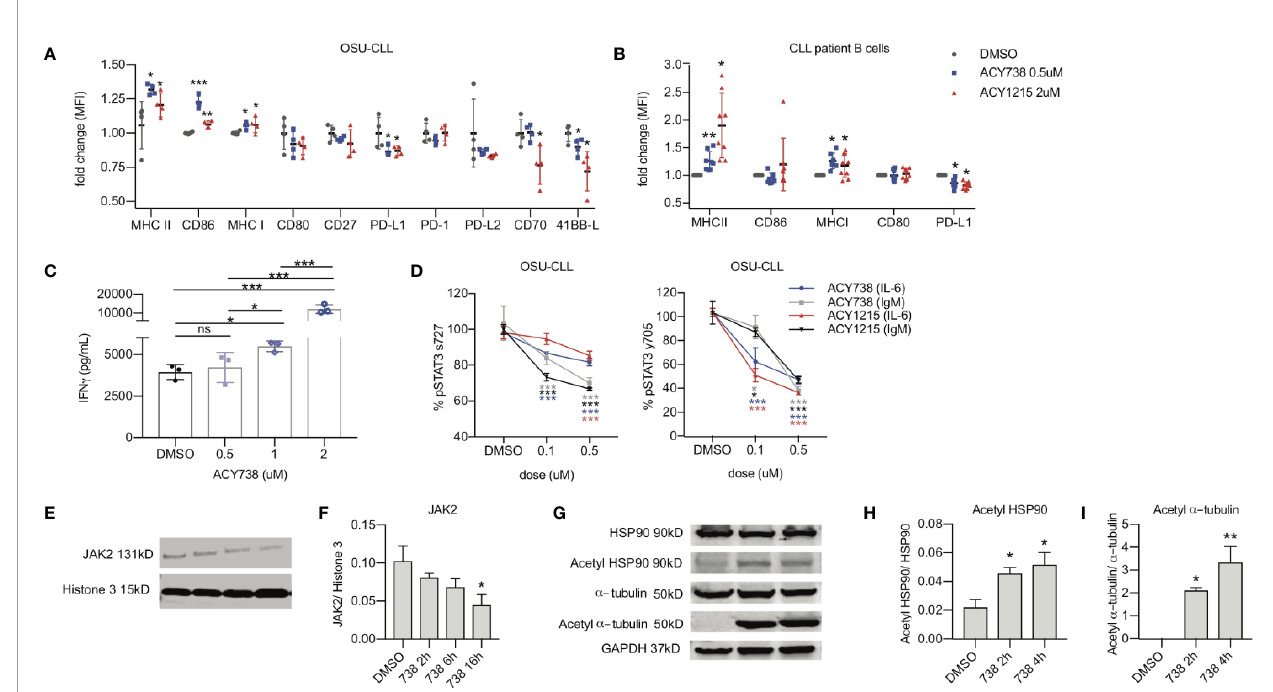
FIGURE 4 | Effects of HDAC6 inhibition on T-cell engagement and JAK/STAT signaling in CLL (A) Surface expression of antigen presentation and co-stimulatory/co- inhibitory markers in OSU-CLL cell line incubated with selective HDAC6 inhibitors or DMSO for 24 h. Data is compiled from 4 independent experiments. All values are expressed as fold change normalized to the mean of DMSO controls. Graph displays mean + SD. (B) Surface expression of antigen presentation and co-stimulatory/ co-inhibitory markers on the surface of CLL patient B cells (n = 8 patients) incubated with selective HDAC6 inhibitors or DMSO for 24 h. CLL cells were denoted by expression of CD19, CD20 and CD5. All values are expressed as fold change normalized to DMSO controls. Each patient sample was normalized to its own DMSO control to account for inter-patient variability in antigen expression. Graph displays mean + SD. (C) Antigen presentation assay. E m -TCL1 B cells were pre-treated with ACY738 at indicated concentrations for 24 h. They were then washed and an equal number of viable cells from each dose condition were loaded with OVA peptide and co-cultured with OTII CD4 + T cells for 24 h in a 1:2 B cell:T cell ratio. IFN g secretion into supernatant was quanti fi ed by cytokine bead array. Representative of 3 independent experiments. Graph displays mean + SD. (D) Phospho-STAT3 protein levels in OSU-CLL treated with ACY738 for 24 h were detected by fl ow cytometry. Cells were plated at a density of 1 × 10 6 per ml and stimulated with soluble anti-human IL-6 at 20 ng/ml for 15 min or plate-bound anti- human IgM at 10 ug/ml for 50 min. All values are expressed as a percentage of DMSO controls. Data are compiled from 3 independent experiments. Graphs display mean + SD. (E) Immunoblotting analysis for JAK2 protein in OSU-CLL cells treated with ACY738 at 0.5uM collected at indicated time points. (F) Densitometry quantifying JAK2 expression, normalized to histone 3 loading control. (G) Immunoblotting analysis for acetylation of HSP90 and a -tubulin in OSU-CLL cells treated with ACY738 at 0.5uM collected at indicated time points. (H, I) Densitometry quantifying acetylation of HSP90 and a -tubulin. Normalized to total protein control. Immunoblots shown are representative of three independent experiments and densitometry graphs display data compiled from 3 independent experiments. Graphs display mean + SD. * p < 0.05, ** p < 0.005, *** p < 0.0005. ns, not signi fi